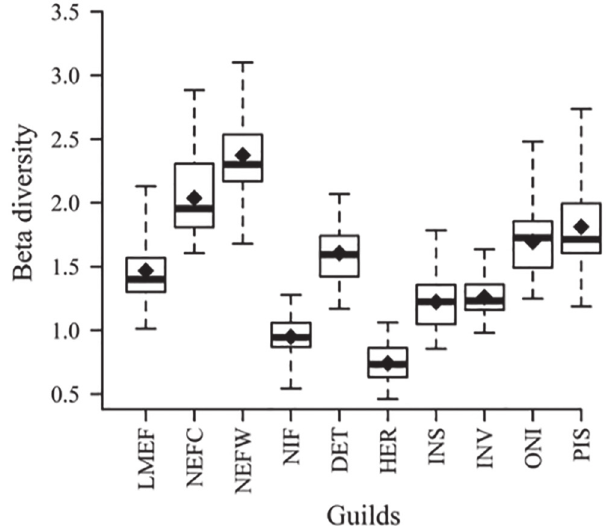
Fig. 4. Beta diversity variation among the guilds. The boxes represent the interquartile ranges, the horizontal lines indicate the medians, the bars indicate the minimum and maximum values, and the closed diamonds represent the mean beta diversity of each guild. LMEF: long-distance migratory and external fertilization; NEFC: non-migratory with external fertilization and parental care; NEFW: non- migratory with external fertilization without parental care; NIF: non-migratory with internal fertilization; DET: detritivorous; HER: herbivorous; INS: insectivorous; INV: invertivorous; ONI: omnivorous; and PIS: piscivorous.